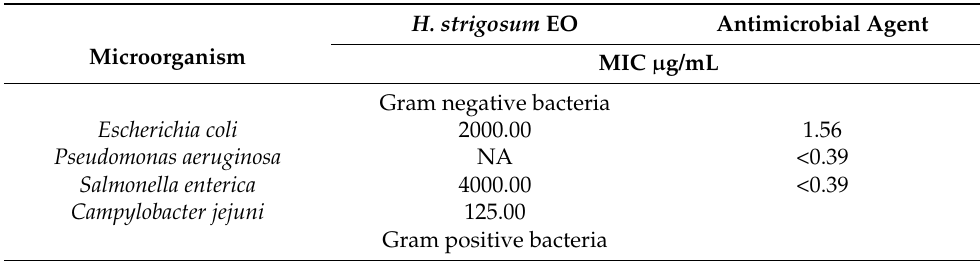
Table 3. Minimum inhibitory concentration calculated for H. strigosum essential oil against ten human pathogenic